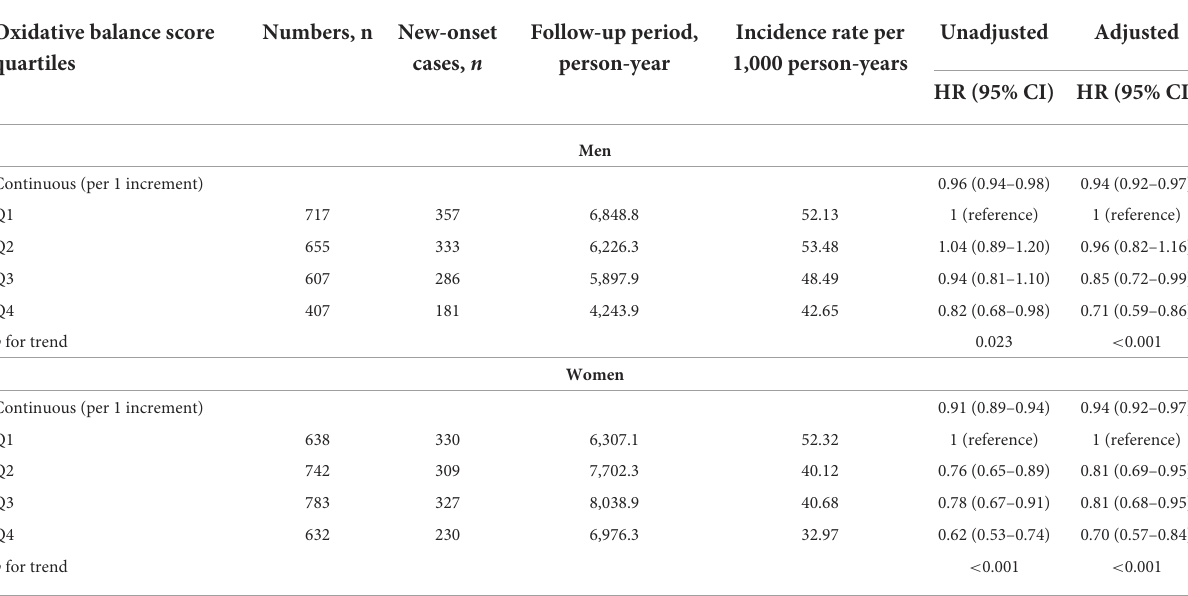
TABLE 4 Cox proportional hazard regression analysis showing the relationship of oxidative balance scores with incident non-alcoholic fatty liver disease. Oxidative balance score